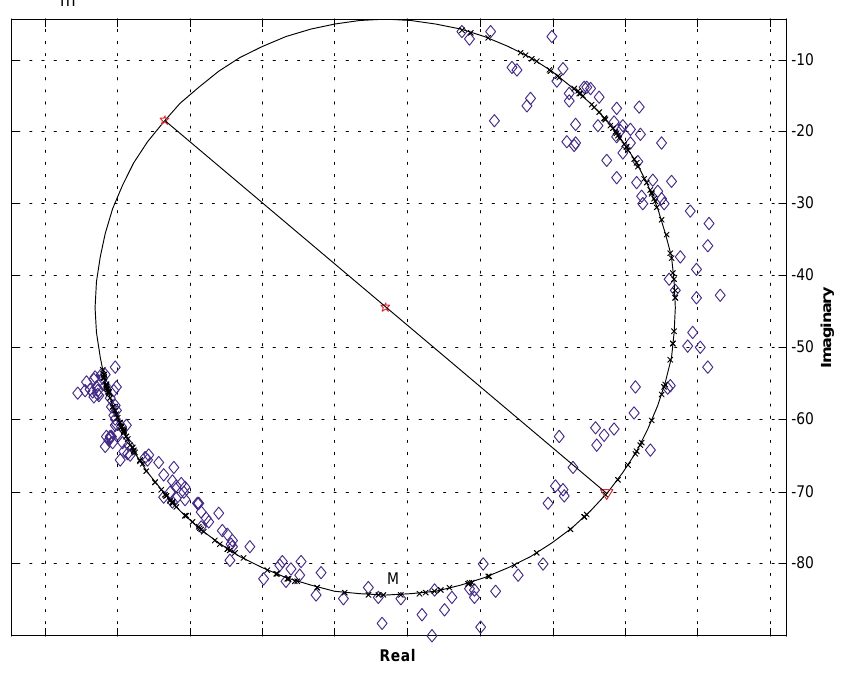
Fig. 8. Circle fit to apparent mass frequency response function for 47 kg standing human.